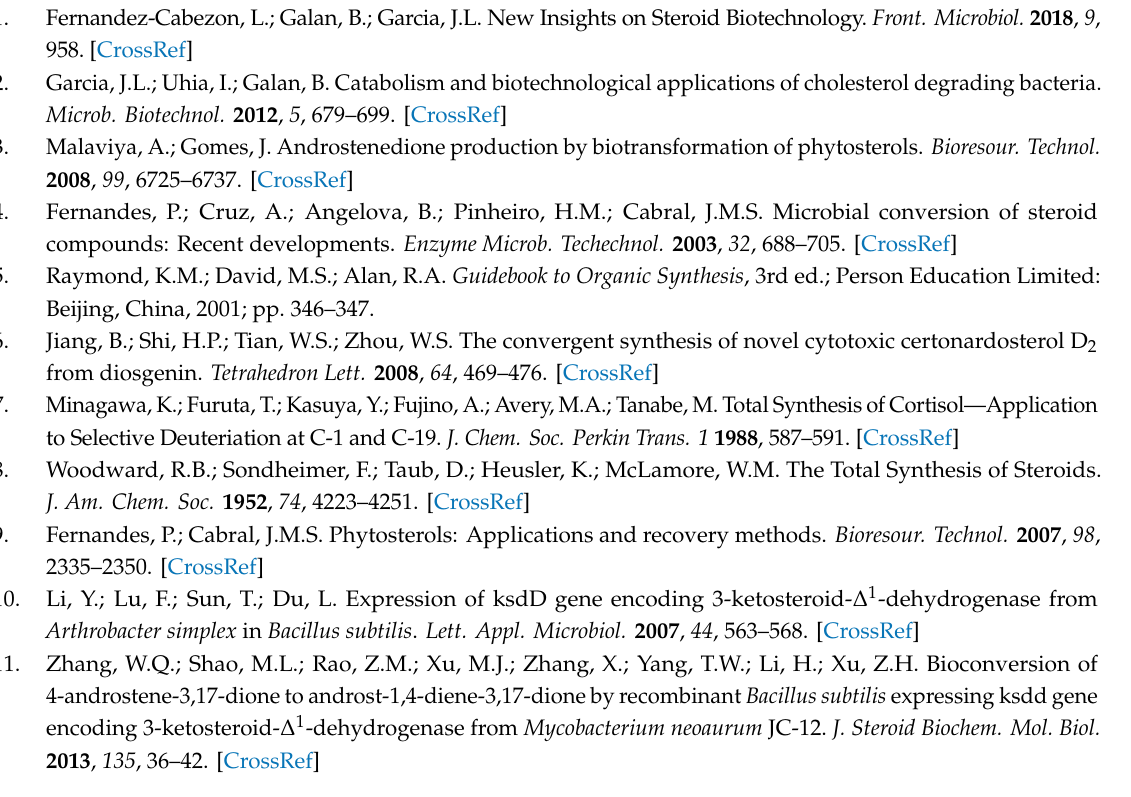
Figure S1: The analysis diagram of transmembrane region by TMHMM, Figure S2: Growth curve of recombinant strains, Table S1: Microorganisms, plasmids and primers used in the